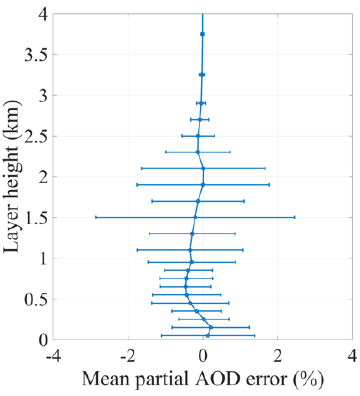
Figure 12. Mean partial layer AOD error ± 1 standard deviation.